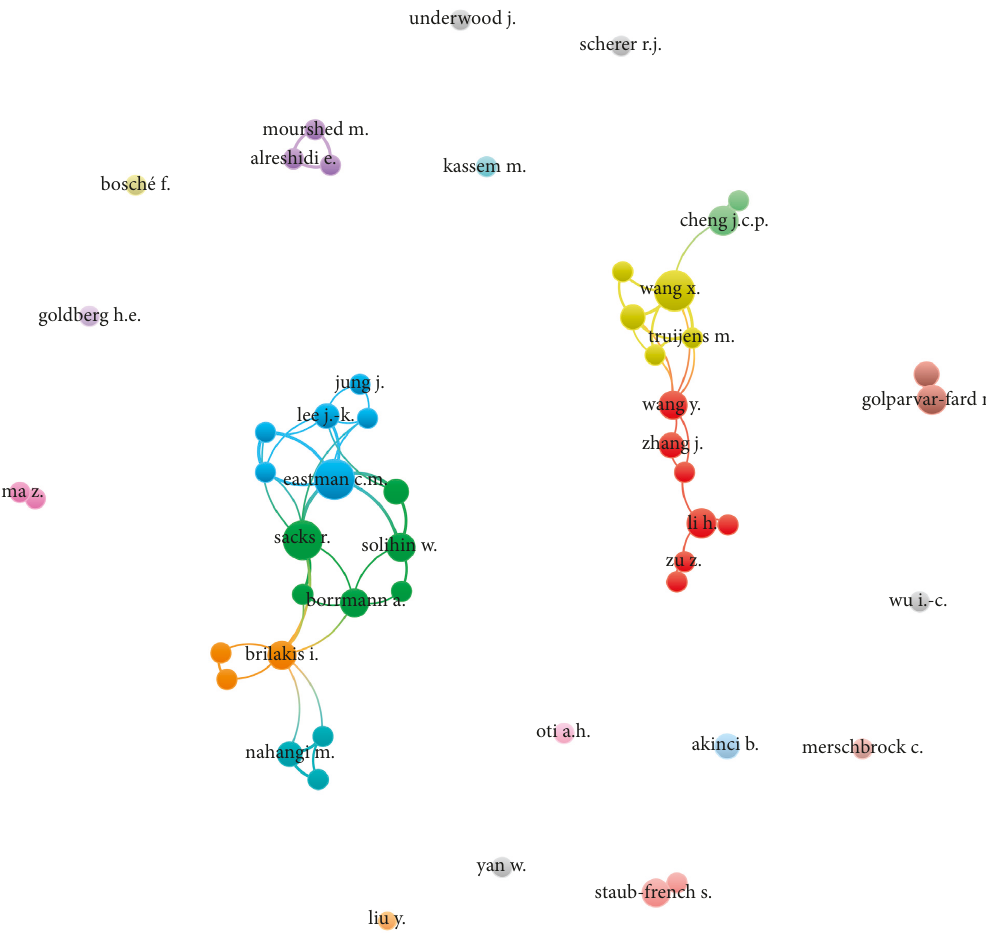
Figure 3: Coauthorship network of authors.